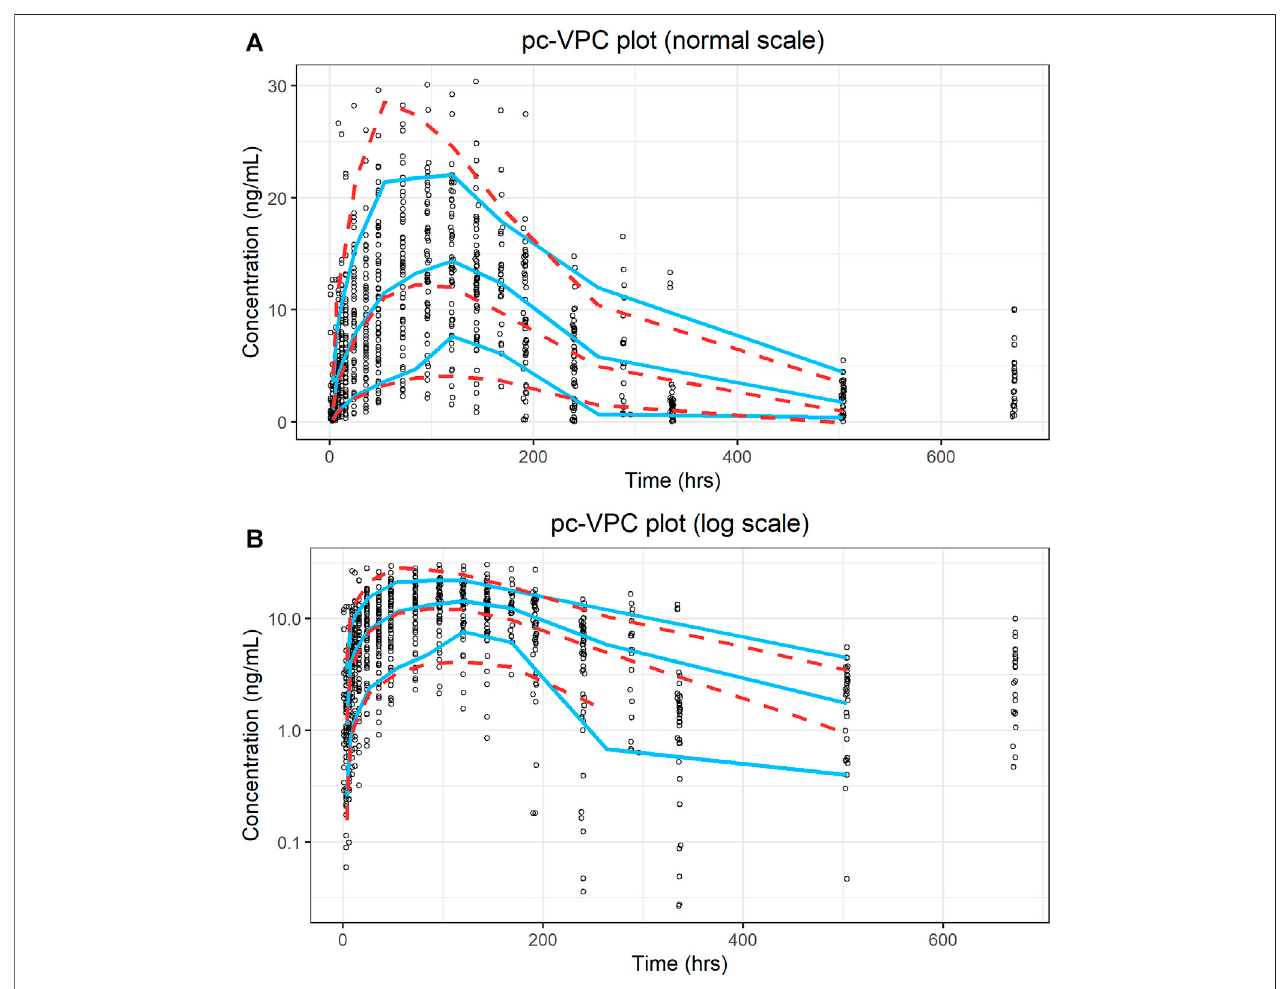
FIGURE5| Prediction-correctedvisualpredictivecheckplotforthe fi nalmodel. (A) Ordinarycoordinate; (B) Semi-logarithmiccoordinate.Bluesolidlinesrepresent the 10th, 50th, and 90th percentiles of the observations; red dashed lines represent the 10th, 50th, and 90th percentiles of the simulated values.